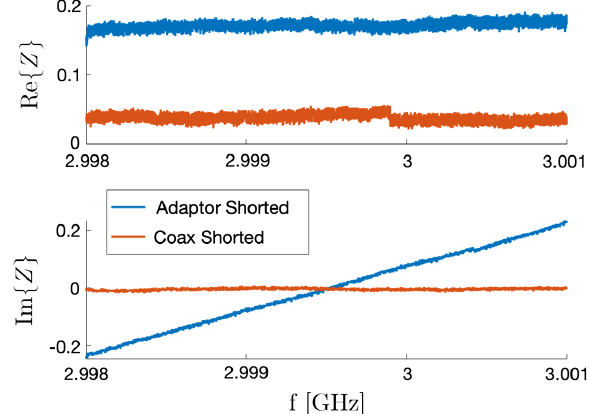
component.FIG. 9. E at the longitudinal center of the designed rf cavity z system, where blue is a minimum in the field, orange maximum, and green